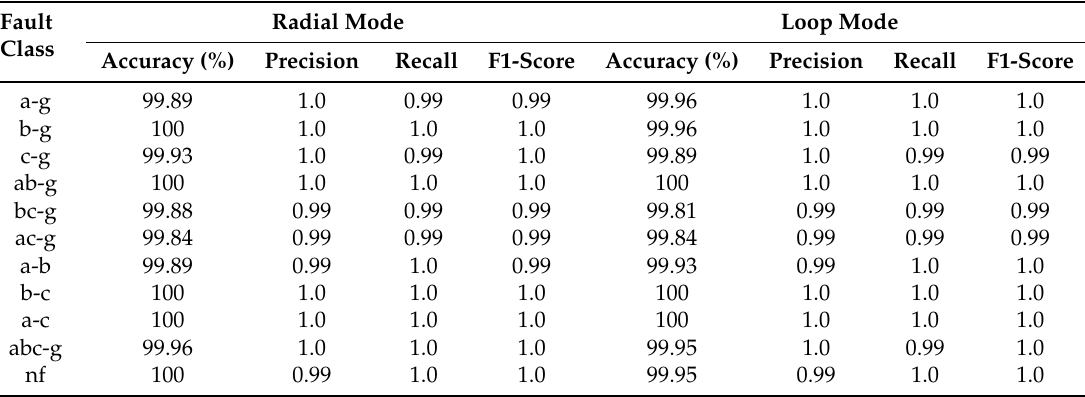
Table 3. Precision, recall, F1-score, and individual class accuracy of the proposed classifier for grid-connected radial mode and grid-connected loop mode operation.